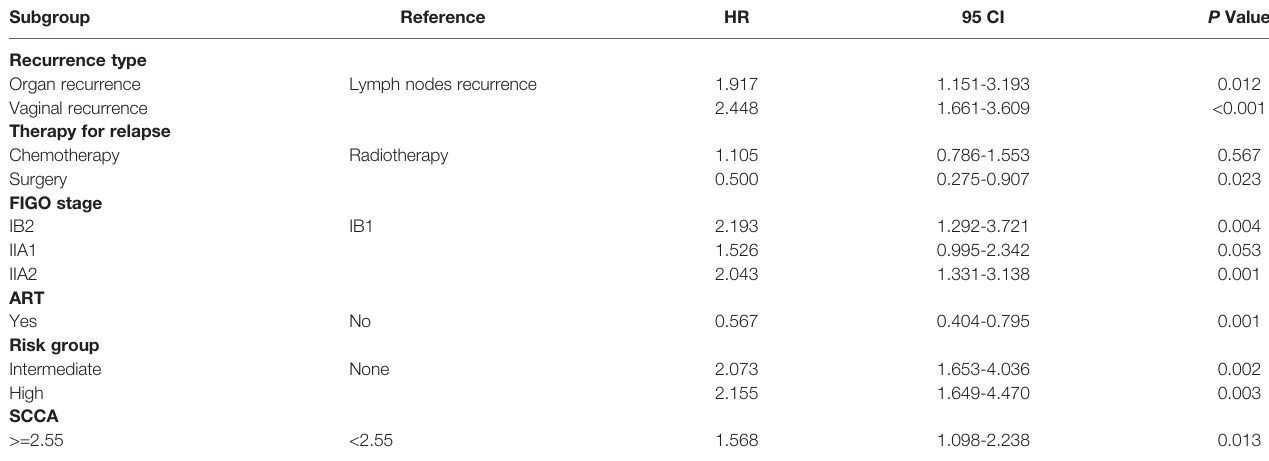
TABLE 4 | Multivariate Cox proportional hazards models for 5-year overall survival. Subgroup